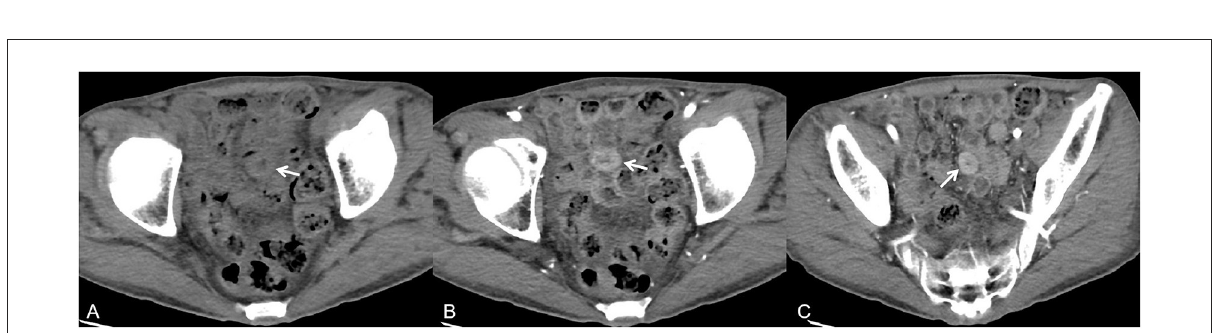
FIGURE4 A 57-year-old man presented with cough, sputum, malaise, dizziness or headaches, and abdominal pain for 1 month. Axial non-contrast-enhanced CT imaging showed multiple regions of thickening of the intestinal wall [ (A) , white arrow]. Axial contrast-enhanced CT images showed lesions with obvious enhancement [ (B,C) , white